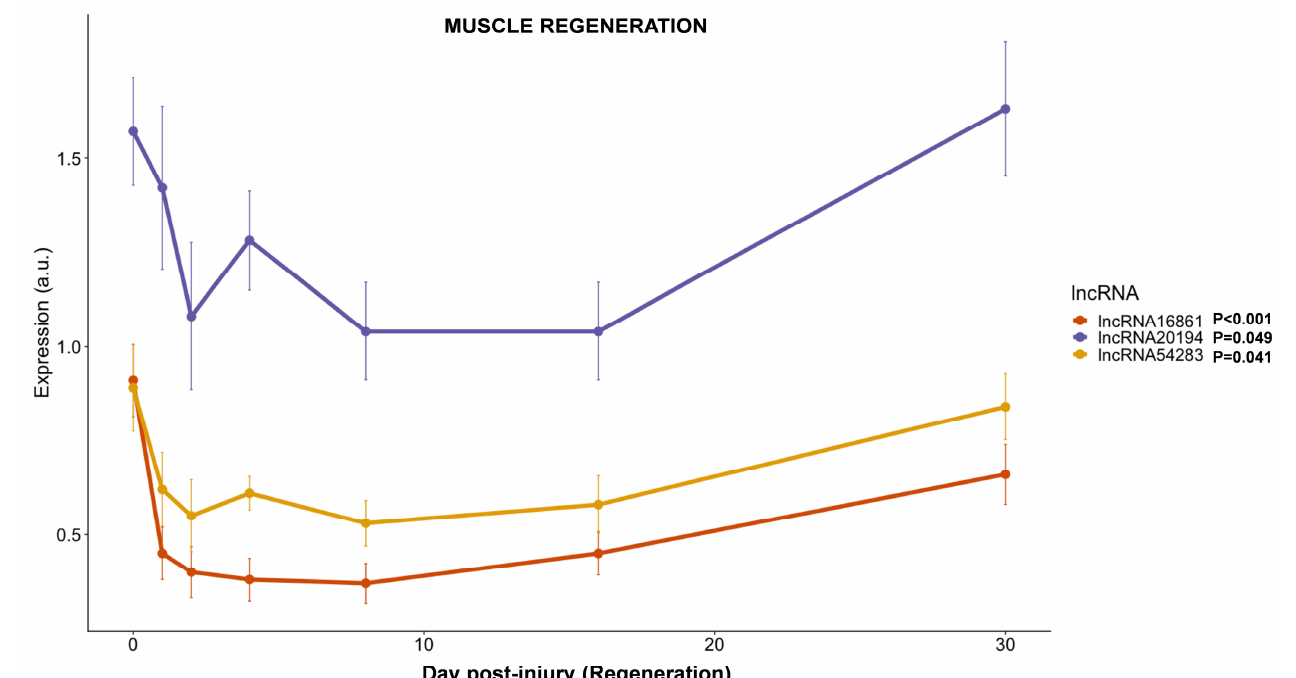
Figure 7. LncRNAs transcription in response to induced muscle injury. Plot showing the gene expression of three lncRNAs during 30 days of regeneration after an induced injury in the epaxial fast skeletal muscle of gilthead sea bream juveniles. Gene expression is expressed as average ± SD ( n = 6) of arbitrary units (a.u). The statistical effect of muscle regeneration is indicated for each lncRNA analyzed.